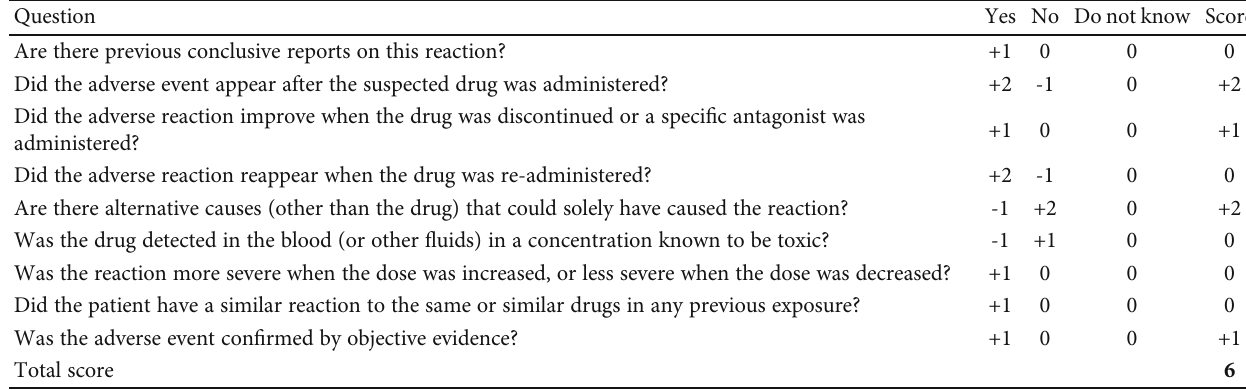
Figure 3: Electrocardiogram revealed a sinus rhythm with slight ST elevation in leads V4 and V5. The QTc was 425 ms, a reduction of 9.2% as compared to the previous reading. Table 1: The Naranjo algorithm to assess the causality. Total score categories are de fi ned as follows: Adverse Drug Reaction (ADR) is: certain > 9; probable 5-8; possible 1-4; unlikely